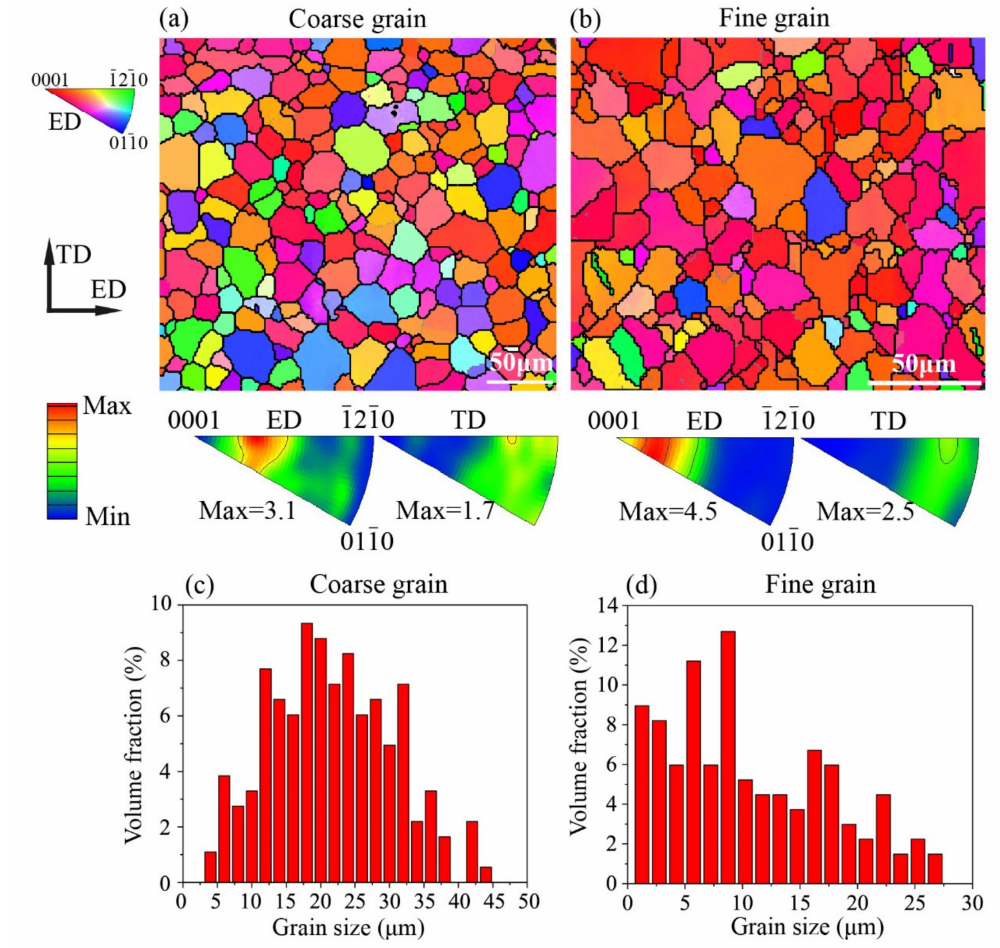
Figure 2. The initial microstructures and the grain size distribution of the samples with different grain sizes in terms of OIMs with the ED inverse pole figure (IPF) coloring and the ED and TD IPFs. ( a ) OIM of coarse grain sample, ( b ) OIM of fine grain sample, ( c ) grain size distribution of the coarse grain sample, and ( d ) grain size distribution of the fine grain